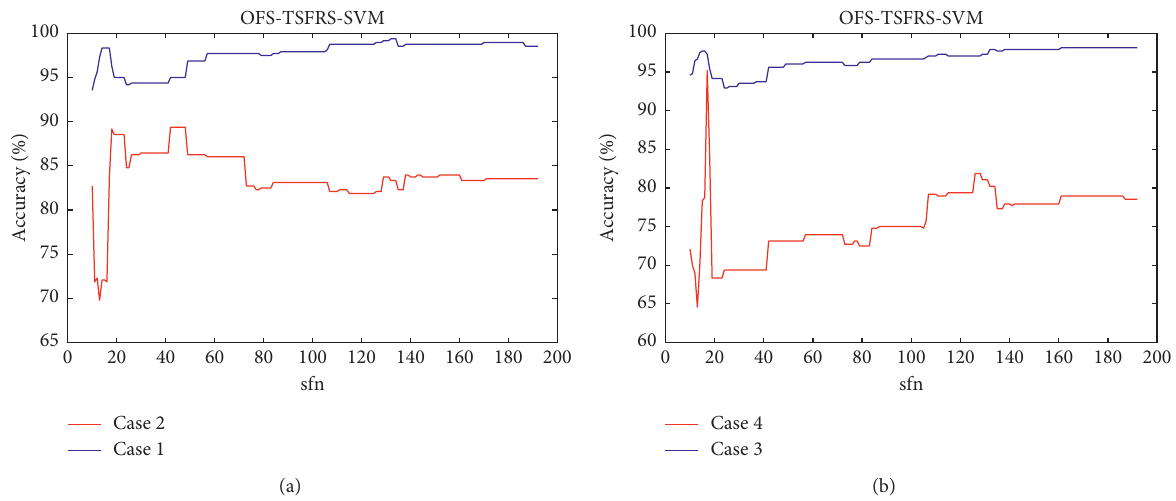
Figure 6: The curve representation of the diagnosis results of OFS-TSFRS-SVM using DTCWPT with different sfn.